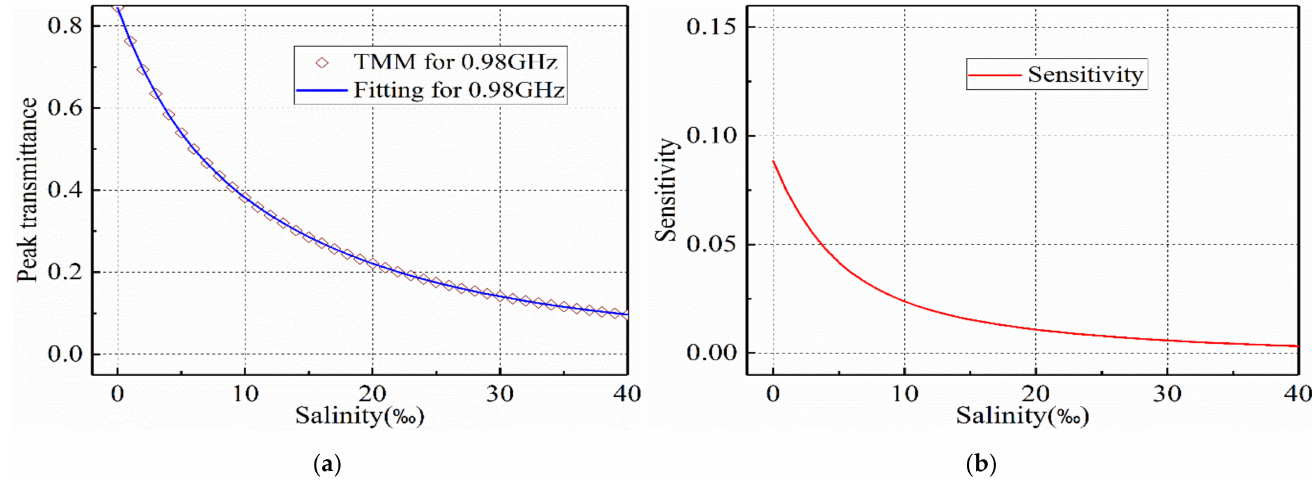
Figure 7. ( a ) Peak transmittance of the Fabry-Perot cavity resonance, and ( b ) the detecting sensitivity of the peak transmit- tance versus salinity for the 3-layer Fabry-Perot cavity sensor.